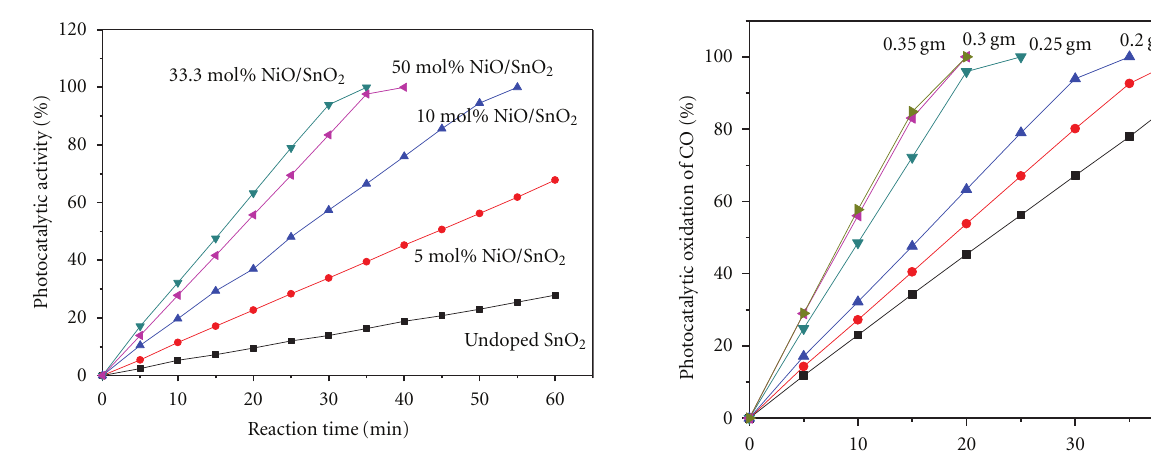
Figure 8: Photooxidation of CO over pure and nickel-doped SnO 2 nanoparticles.